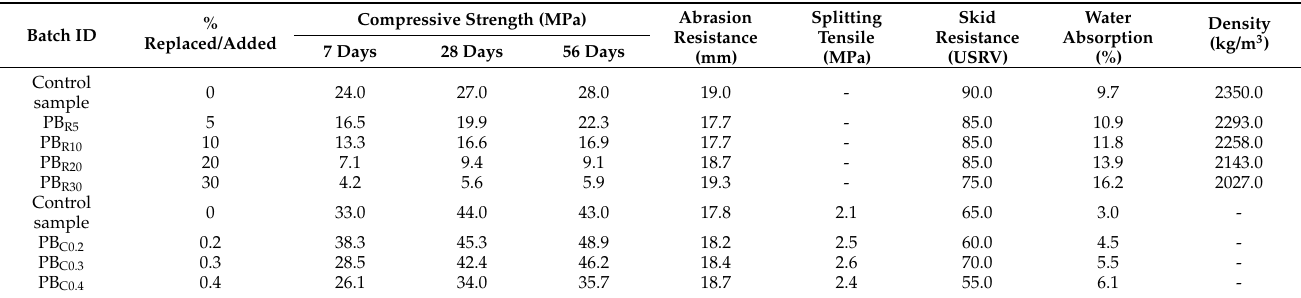
Table 3. Summary of the test results.